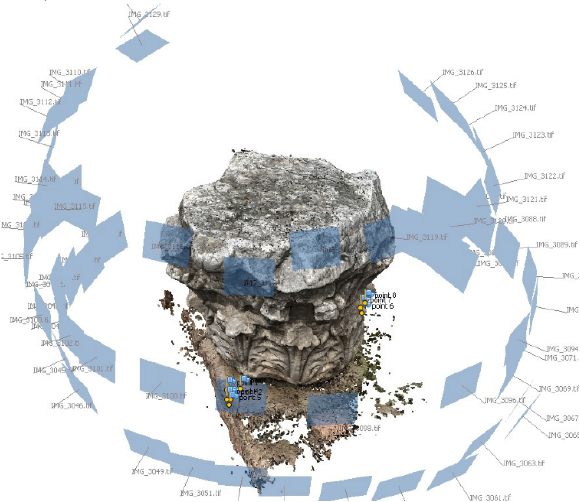
Figure 5: Structure From Motion photographic detection method applied to a single archaeological find in the archaeological area.